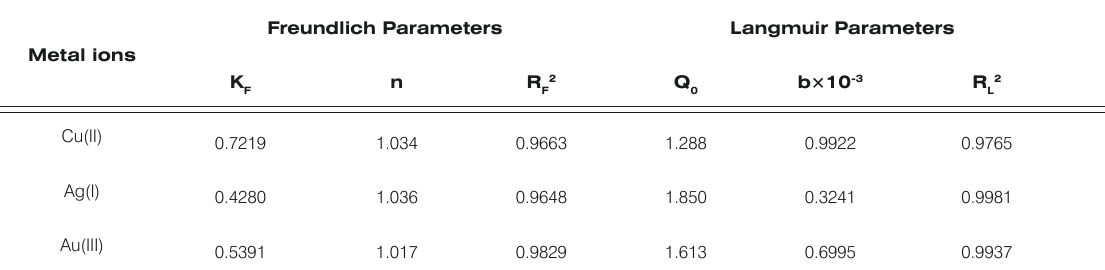
Table 2. Freundlich and Langmuir constants of SG-PS-azo-SA for Cu(II), Ag(I), Au(III)